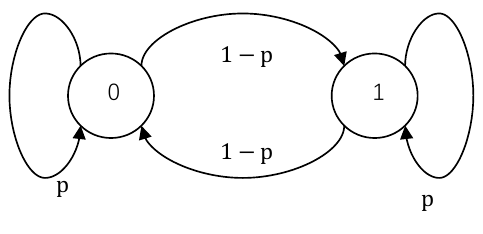
Figure 3. State transition diagram of a two-state Markov